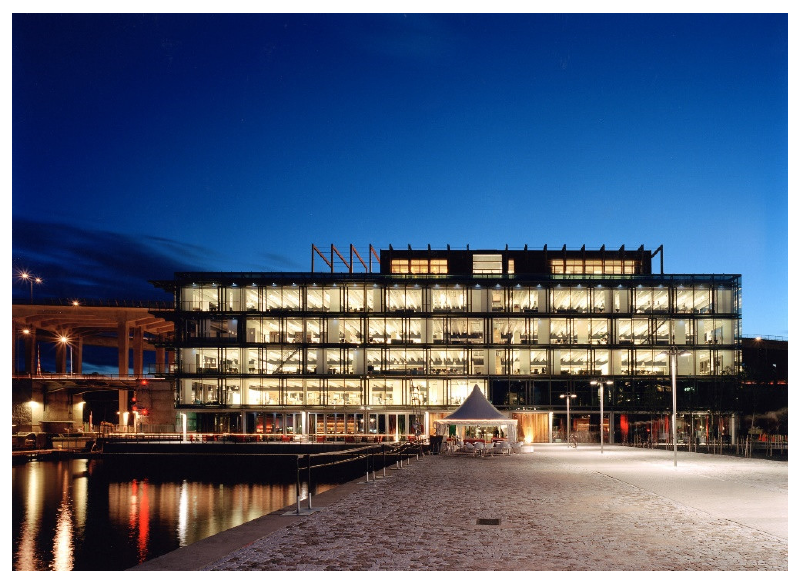
Figure 8. Katsan office block for White architects. An open office structure with glass façades facing east and west and water from the canal used for cooling. Photo White architects.